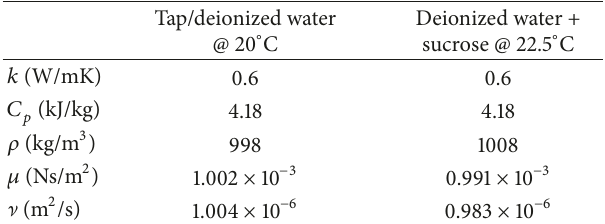
Table 1: Physical properties for tap/deionized water and for the mixture of deionized water and sucrose 2.7 wt%. In the table thermal conductivity 𝑘 , specific heat 𝐶𝑝 , density 𝜌 , dynamic viscosity 𝜇 , and kinematic viscosity ] are